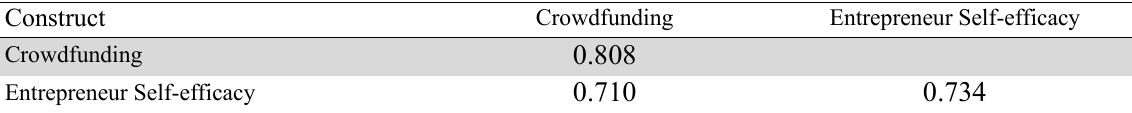
Discriminant Validity Index Summary